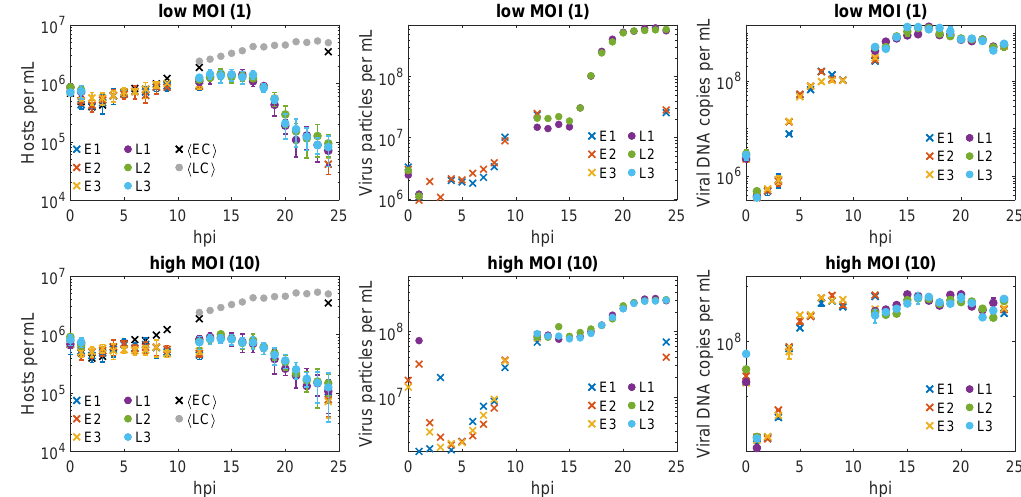
Figure 2. Infection dynamics at low and high MOI. ( Top Row ) For the low MOI case, (left) host densities are estimated from microscopy counting, (middle) external virus particles are estimated from flow cytometry, and (right) total viral DNA copies are estimated from qPCR analysis. The same scheme applies to the high MOI experiments ( Bottom Row ). Samples for the “early” (E) experiment were taken at {0,1,2,3,4,5,6,7,8,9,12,24} h post infection and “late” (L) samples were taken at {0,1,12,13,14,15,16,17,18,19,20,21,22,23,24} h post infection. The numbers refer to replicates. Average host population densities are shown in black for the early control (EC) experiments and in gray for the late control (LC) experiments. Error bars capture variation between technical replicates. There are no error bars for the FCM data because measurements were only performed once for each